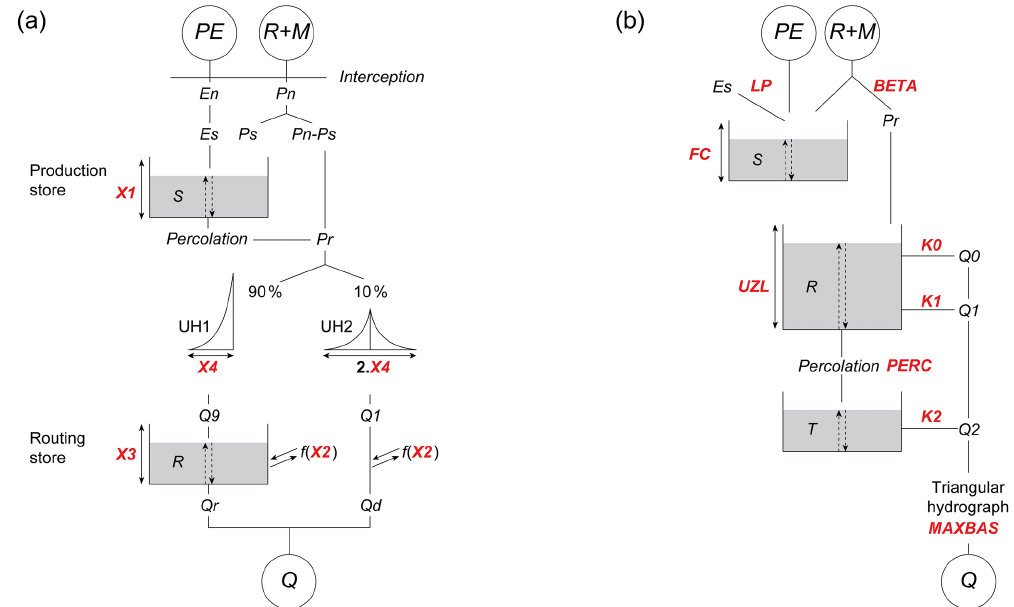
Figure 4. Diagrams of the two hydrological models used: (a) GR4J and (b) HBV9. Calibrated parameters are in red and are further described in Table 3. R , M , PE, and Q stand for rainfall, snowmelt, potential evapotranspiration, and streamflow, respectively. Table 2. Parameters of the snow accounting routine and their associated fixed values or ranges tested in each modelling experiment.